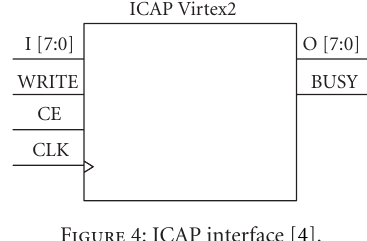
Figure 4: ICAP interface